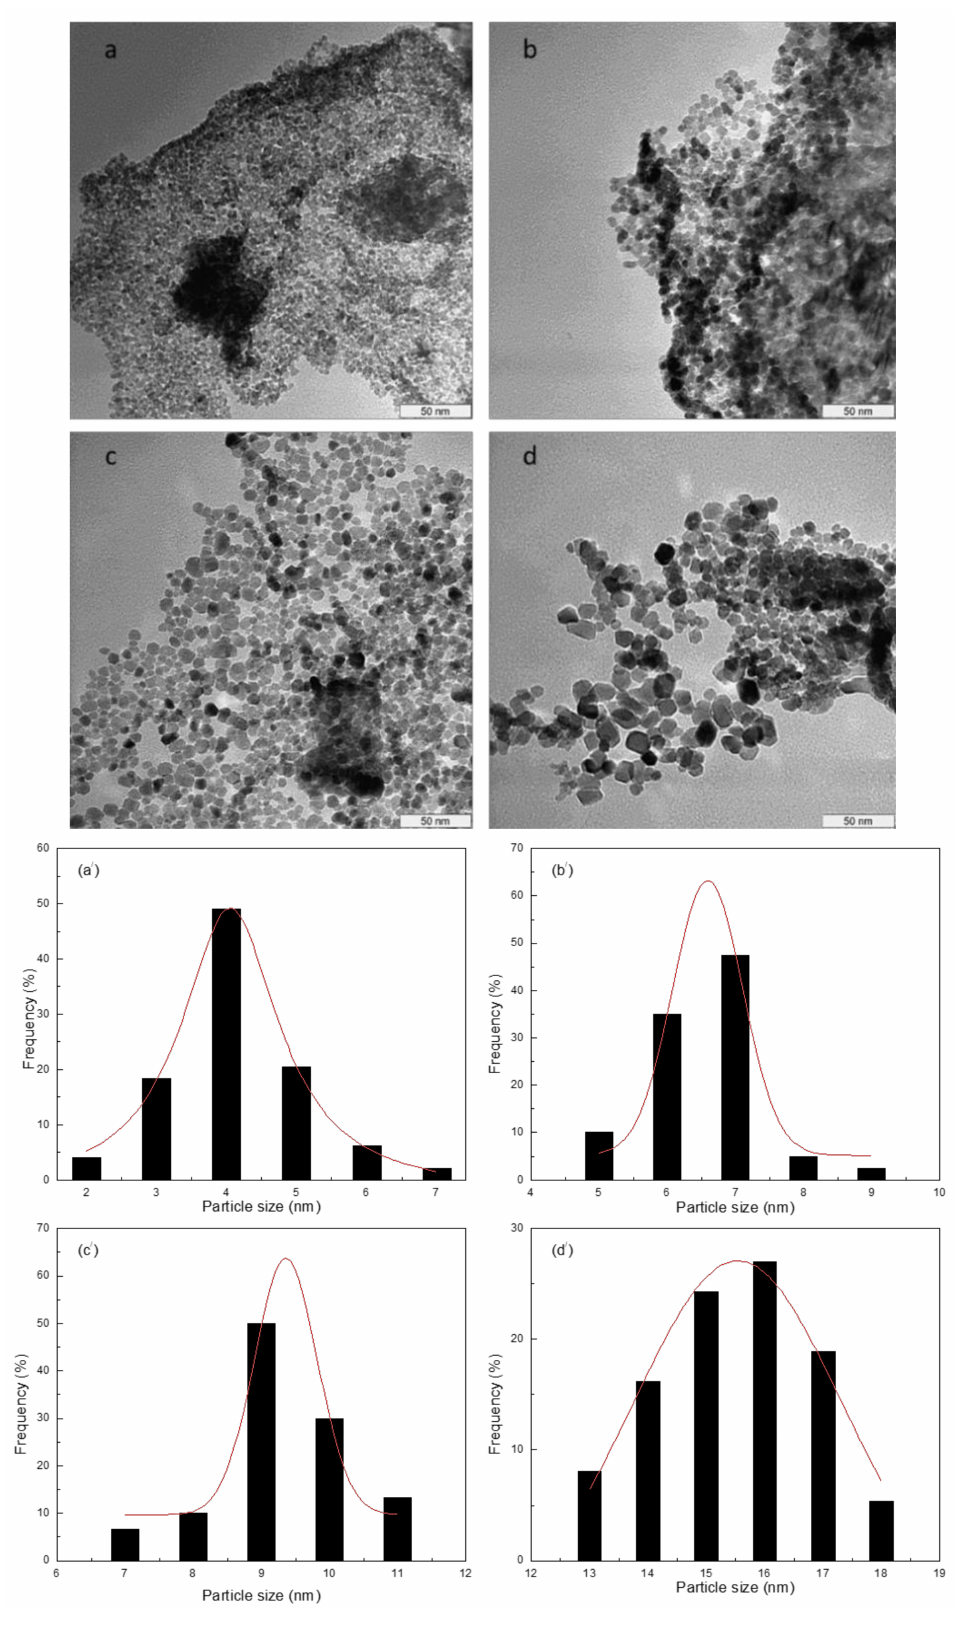
Figure 5. Nanoparticle size distribution histogram and TEM micrographs at calcination temperatures of 500 ◦ C ( a , a’ ) 600 ◦ C ( b , b’ ) 700 ◦ C ( c , c’ ) and 800 ◦ C ( d , d’